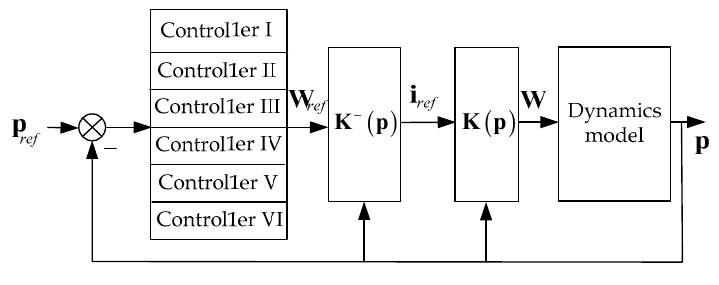
Figure 4. Control system structure.